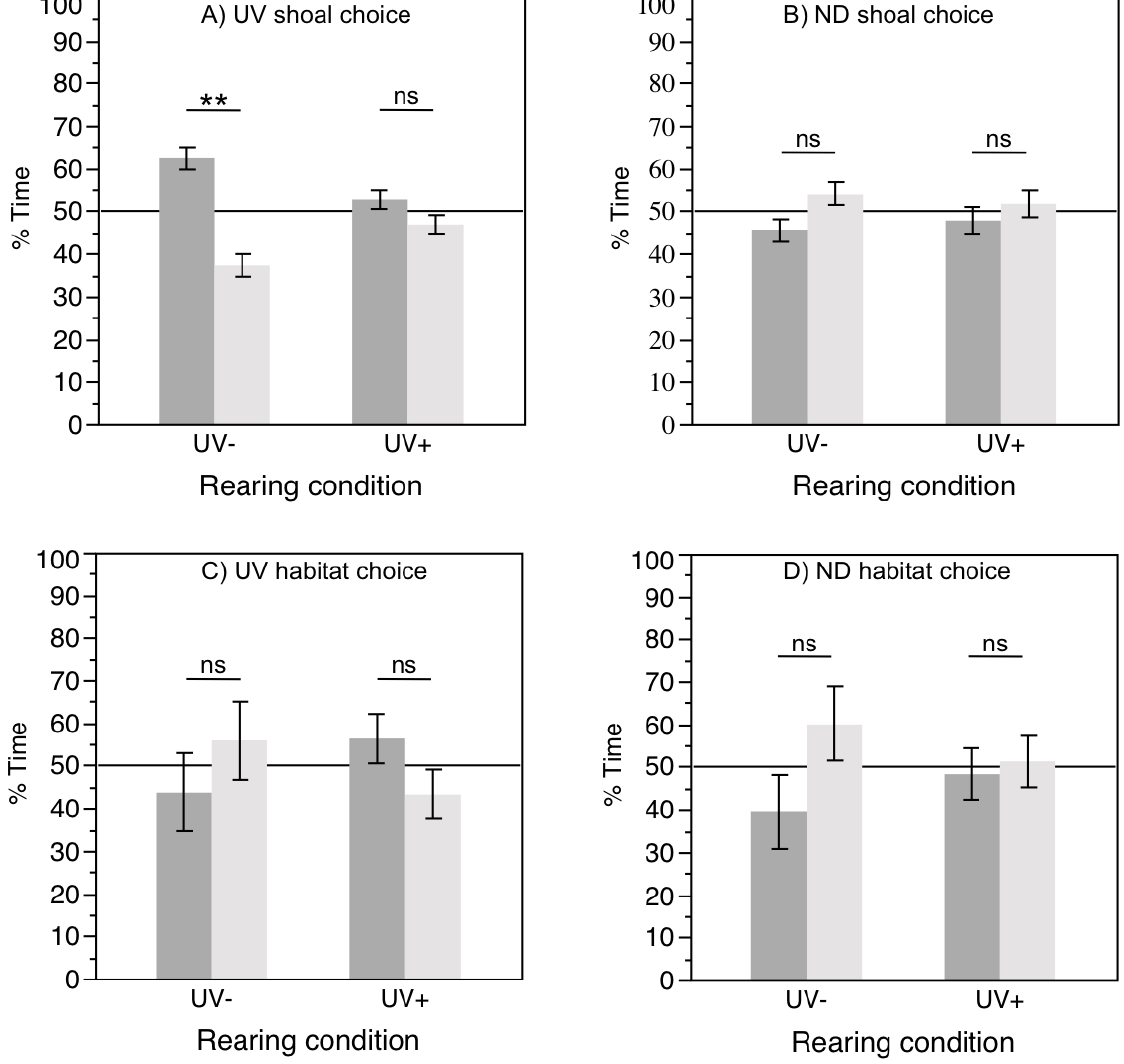
Figure 3 . Mean (± SE ) time in % spent by test fish in front of A) shoals seen through the UV- (dark gray bars) or UV+ (light gray bars) optical filter. Rearing condition (UV-, UV+) significantly influenced shoaling preference; B) shoals seen through the ND2 (dark gray bars) or ND1 (light gray bars) optical filter. Test fish from the two different rearing conditions (UV+, UV-) showed no significant preference for either the ND2 or ND1 shoal; C) compartments (without a shoal) seen through the UV- (dark gray bars) or UV+ (light gray bars) optical filter. Test fish showed no significant UV habitat preference; D) compartments (without a shoal) seen through the ND2 (dark gray bars) or ND1 (light gray bars) optical filter. Test fish showed no significant ND habitat preference. ** p < 0.01, ns = not significant (paired t tests on untransformed data). Lines at 50% indicate random